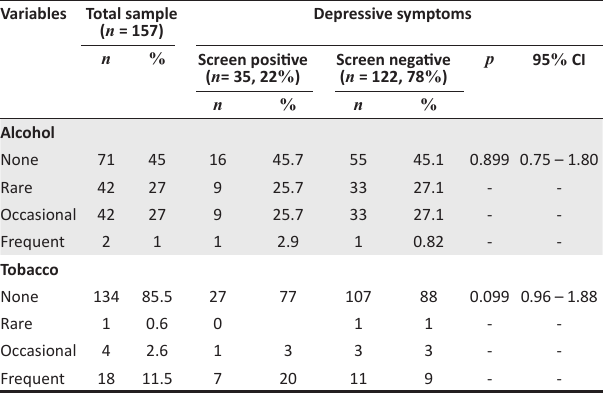
TABLE 3: Baseline substance use characteristics for participants who screened positive versus those who screened negative for depressive symptoms. Variables Total sample ( n = 157)